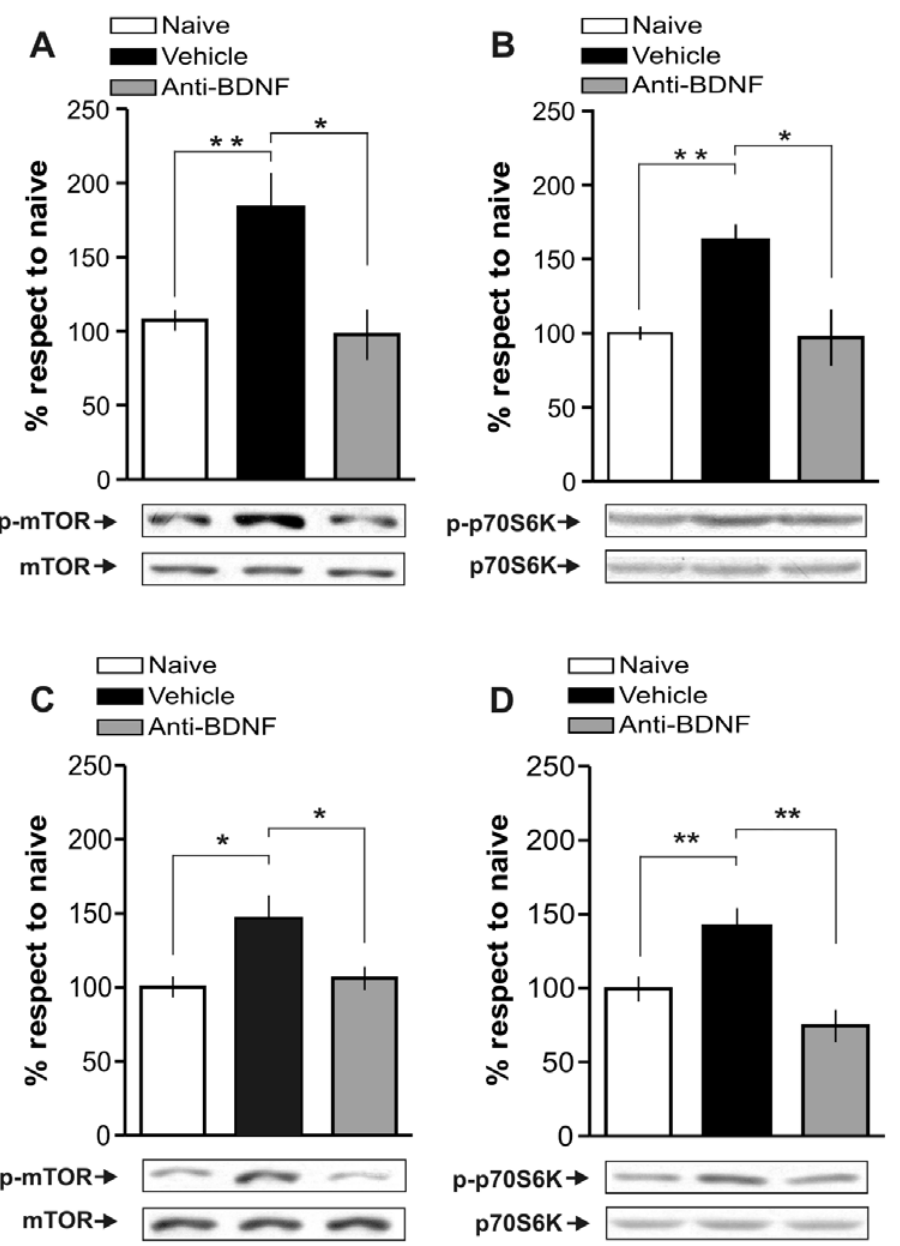
Figure 5. BDNF Triggers mTOR Activation in the Hippocampus During IA Training and 3 h Thereafter. Bars represent mean p-mTOR/ mTOR (A and C) or p-p70S6K/p70S6K ratio (B and D) of rats infused with vehicle (black), function-blocking anti-BDNF antibodies (0.5 m g/side; grey), respect to the naı¨ve group (white). Intra-CA1 infusion of function-blocking anti-BDNF antibodies 15 min before IA training prevents mTOR (A) and p70S6K (B) activation immediately or 15 min after training respectively and infusion 2:45 h after training prevents mTOR (C) and p70S6K (D) activation 3 h after training. Representative blots of phosphorylated and total protein levels of mTOR and p70S6K are shown in the lower panels. *p , 0.05, **p , 0.01, n=5–6 per group for each experiment.